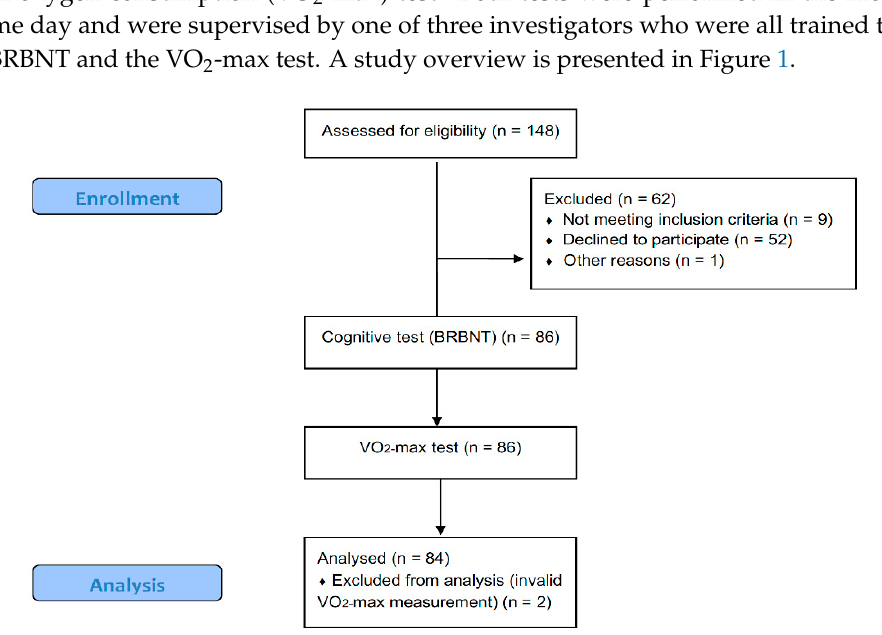
Figure 1. Subject enrolment and analysis.